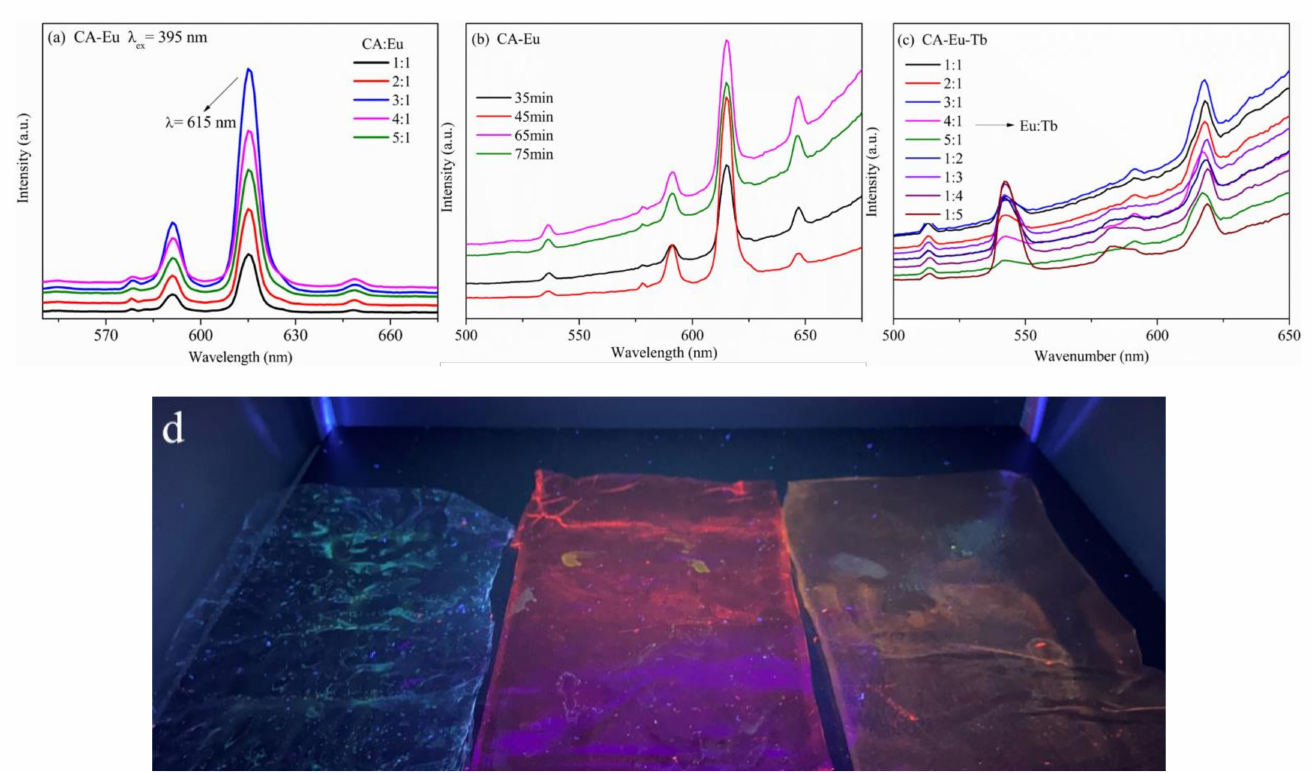
Figure 6. Emission spectra of light conversion films. ( a ) CA–Eu film with different proportions, ( b ) CA–Eu film with different reaction time. ( c ) CA–Eu–Tb film with different Eu 3+ :Tb 3+ ratios, ( d ) the optical photograph of CA and the light conversion films. (From left to right are CA, CA–Eu and